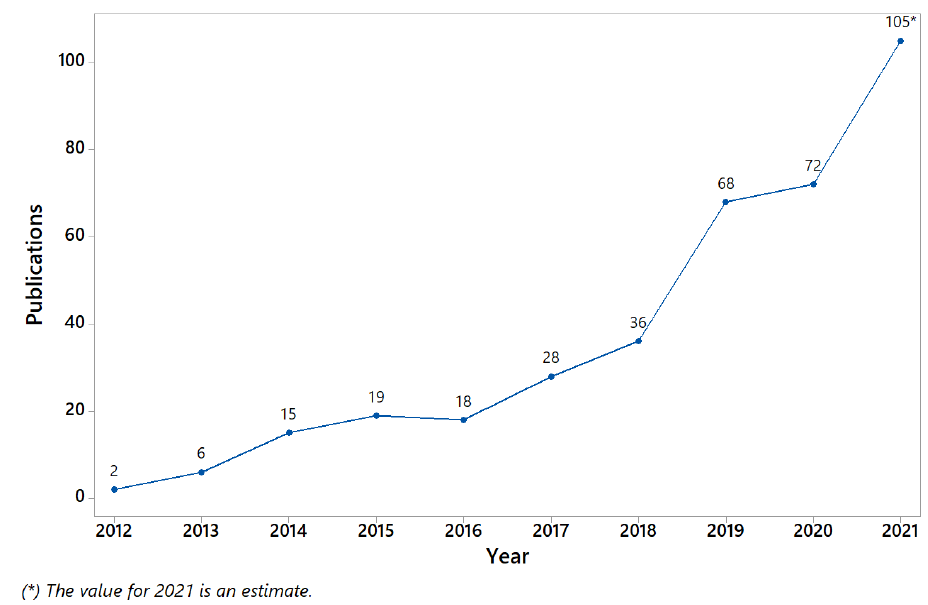
Figure 2. Evolution of related publications in Scopus-indexed